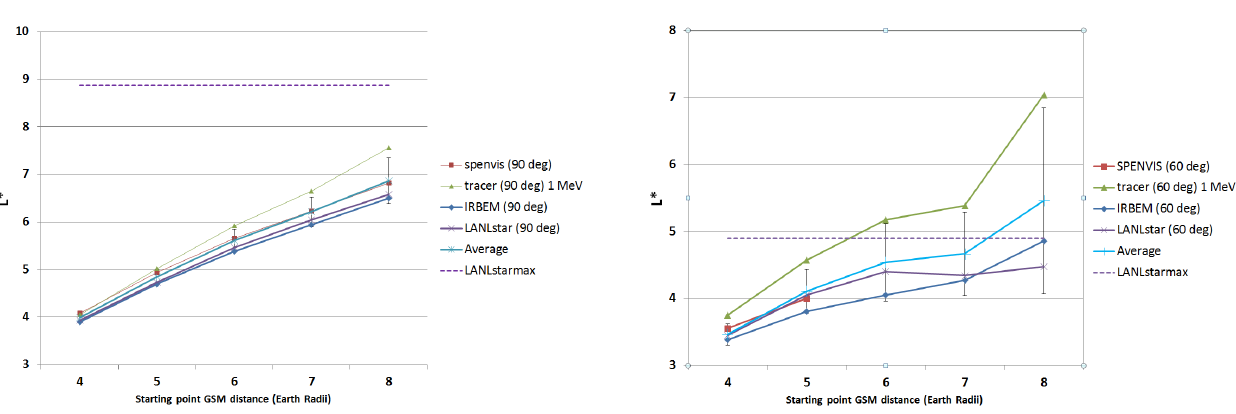
Figure 6. Calculations of L ∗ as a function of initial distance (in R E ) at 00:00MLT, for an initial pitch angle of 90 ◦ during quiet solar wind conditions. Error bars represent the standard deviation between results from the various models.